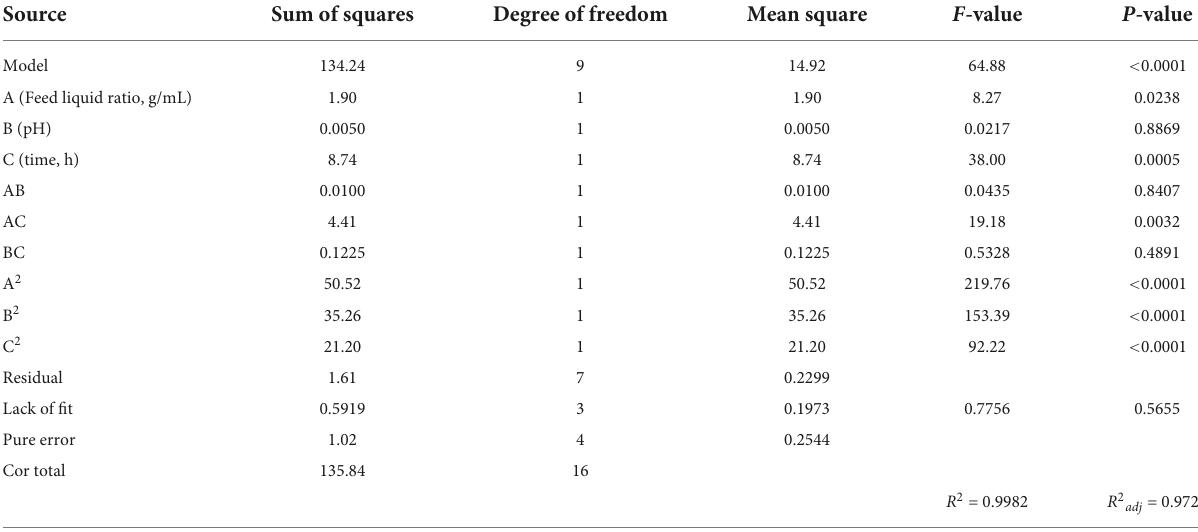
TABLE 4 Analysis of variance of the fitted regression model. Source Sum of squares Degree of